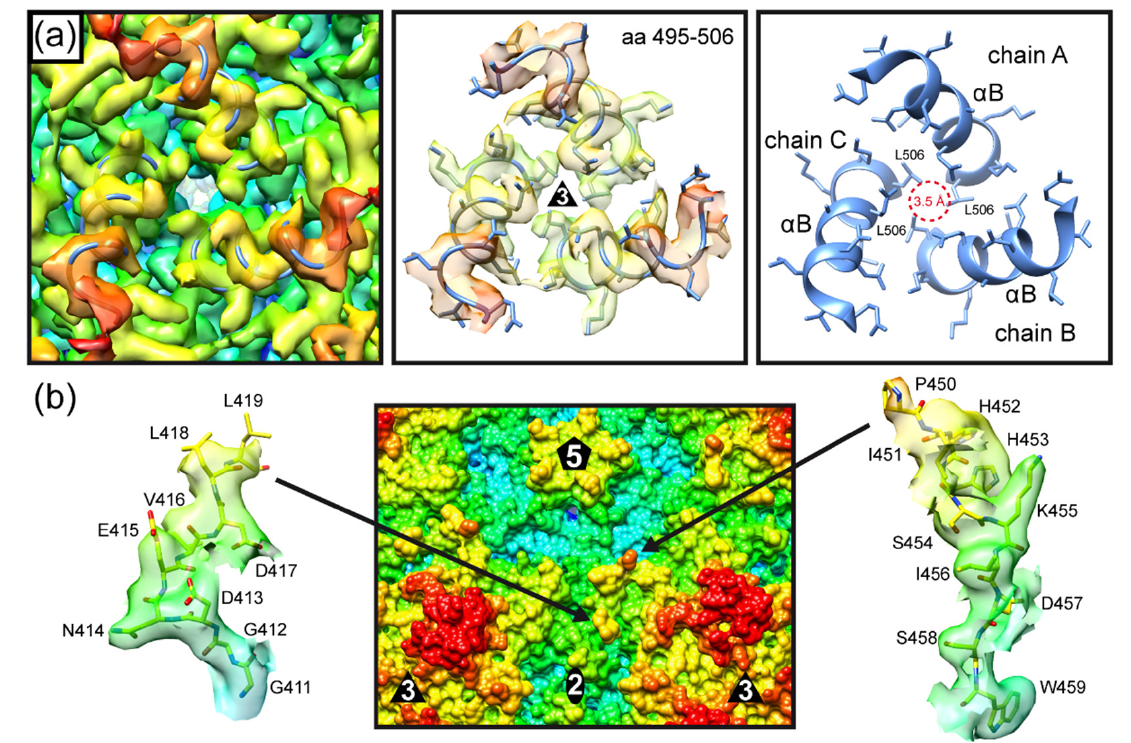
Figure 4. Unique capsid features of AMDV. ( a ) The α -helices B of three symmetry-related monomers are positioned around the three-fold symmetry axis. Left and center panel: the ribbon diagram of aa 495–506 fitted into the density map of AMDV (center panel with amino acid side chains). Right panel: The ribbon diagrams are shown without the map. Leucine 506 is located near the center, surrounding a pore approximately 3.5 Å in diameter. ( b ) AMDV’s cleaved VR-VII is located at the two/five-fold wall. The N-terminal end (leucine 419), shown inside the density map (left), is located closer to the two-fold symmetry axis, while the C-terminal arm of the loop (right model inside the density map) is located closer to the five-fold symmetry axis. No density was observed for aa 420 to 449.